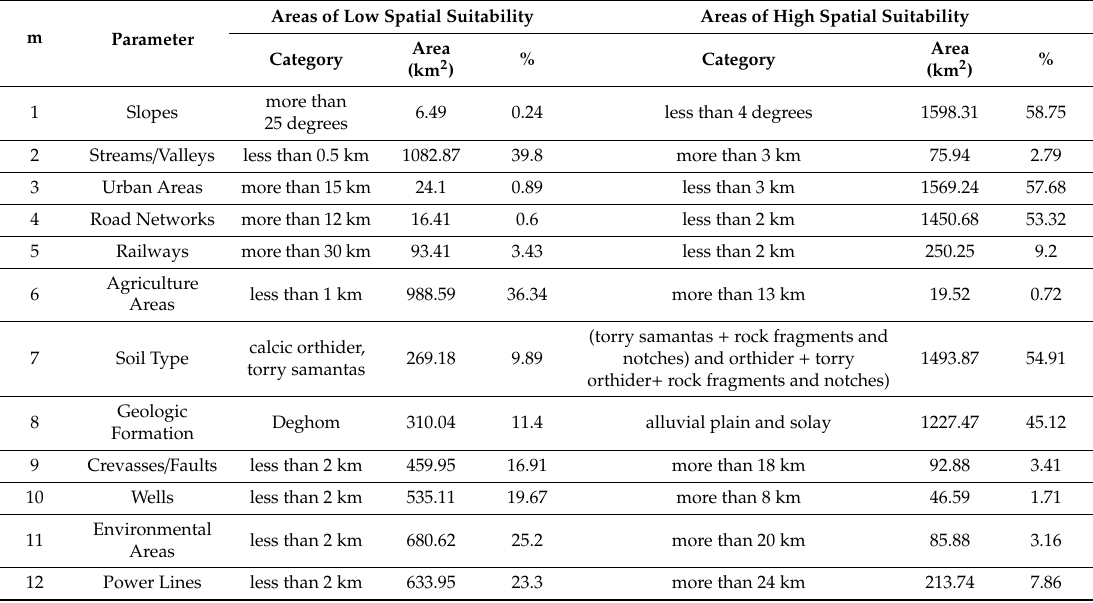
Figure 11. The spatial suitability (part 3) of ( A ) crevasses/faults, ( B ) water sources, ( C ) power lines, ( D ) environmental areas. Table 8. The spatial suitability analysis results for the different criteria affecting the rural–urban continuum area between Ar Riyadh and Al Kharj.